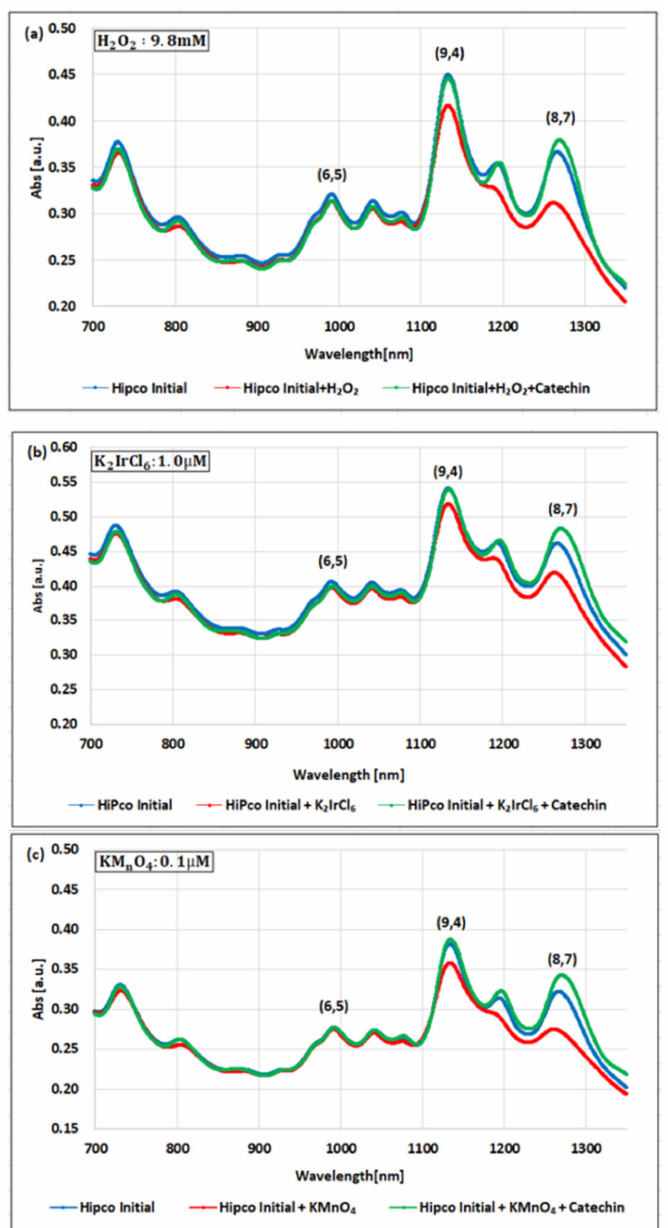
Figure 3. NIR-absorbance spectra of the dsDNA-HiPco SWNT complex during redox with the ( a ) H 2 O 2 and catechin, ( b ) K 2 IrCl 6 and catechin, and ( c ) KMnO 4 and catechin. The data are presented as the average of three independent